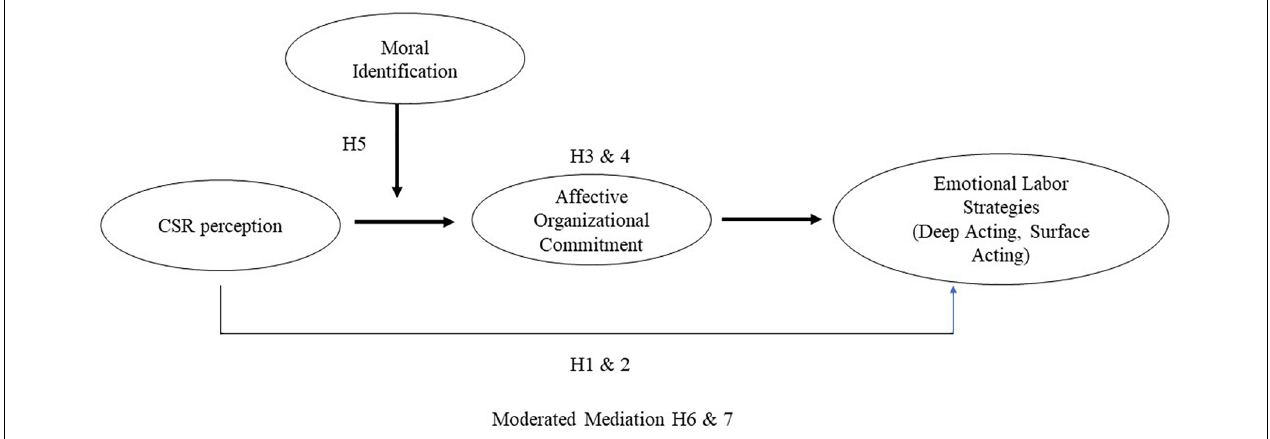
FIGURE 1 | The moderated mediation